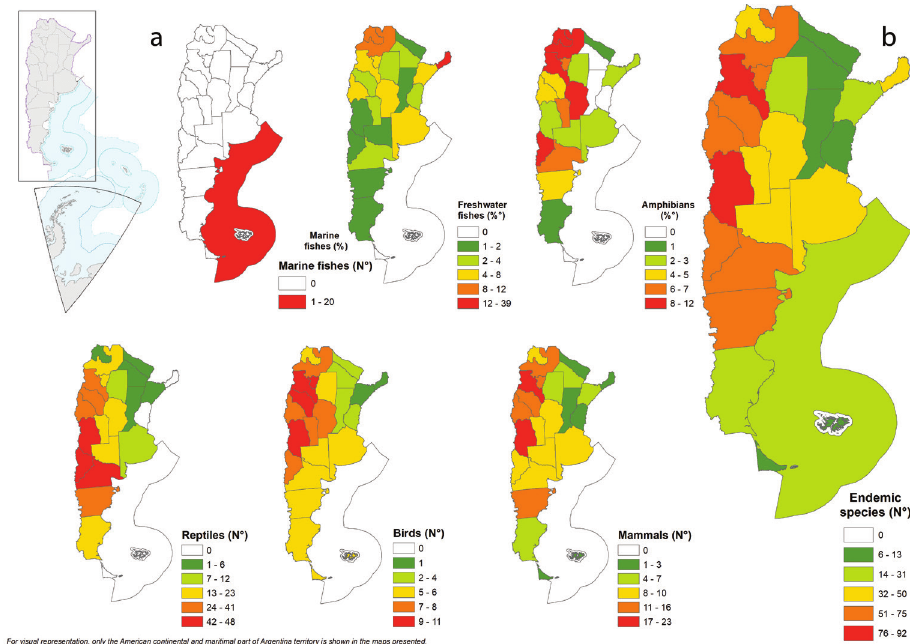
Figure 3. Number of endemics a by group by province b total species by